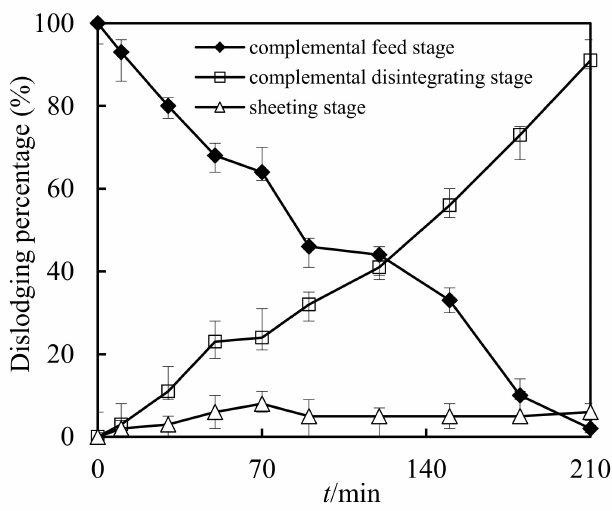
Figure 11. Retention in sheeting stage and impact of